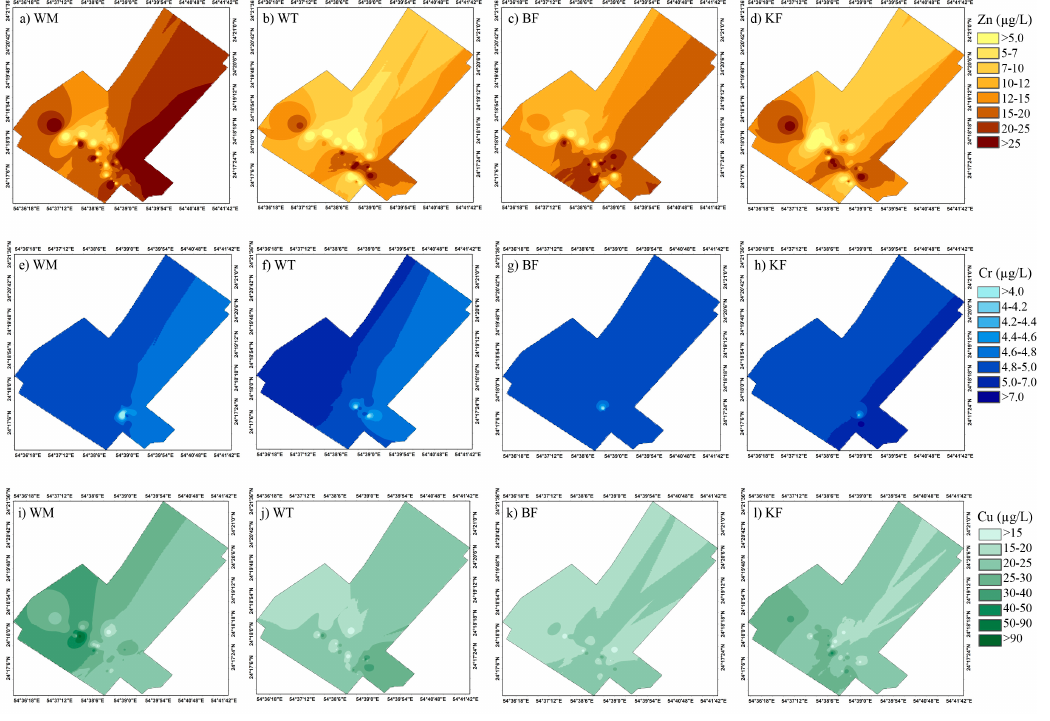
Figure A1. Spatial variation of heavy metals; ( a – d ) Zinc concentrations for the four sampling points WM, WT, BF and KF respectively. ( e – h ) Chromium concentrations for the four sampling points WM, WT, BF and KF respectively. ( i – l ) Copper concentrations for the four sampling points WM, WT, BF and KF respectively.